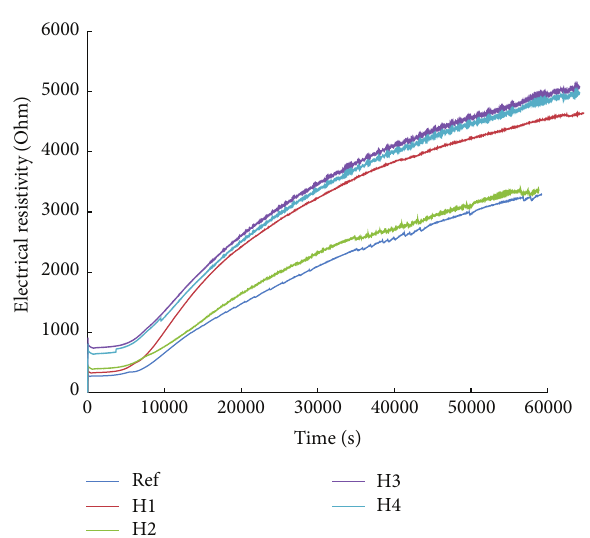
Figure 5: The resistivity-time curves of tested concrete